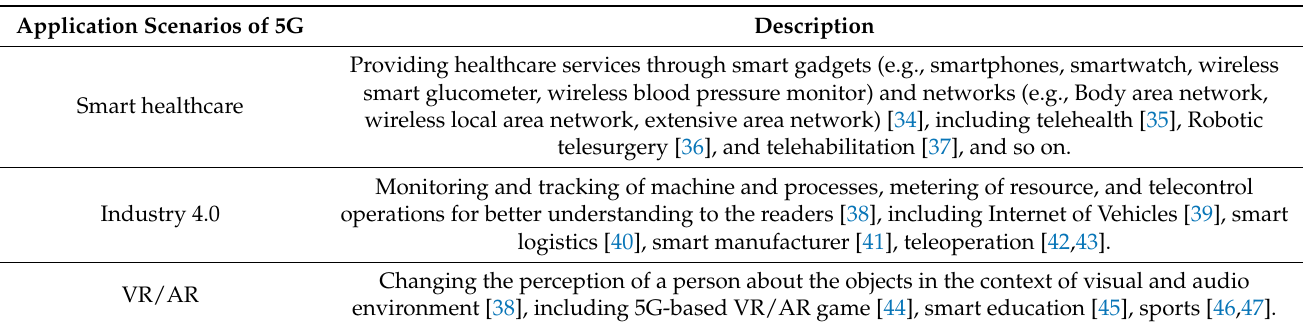
Table 1. Application Scenarios of